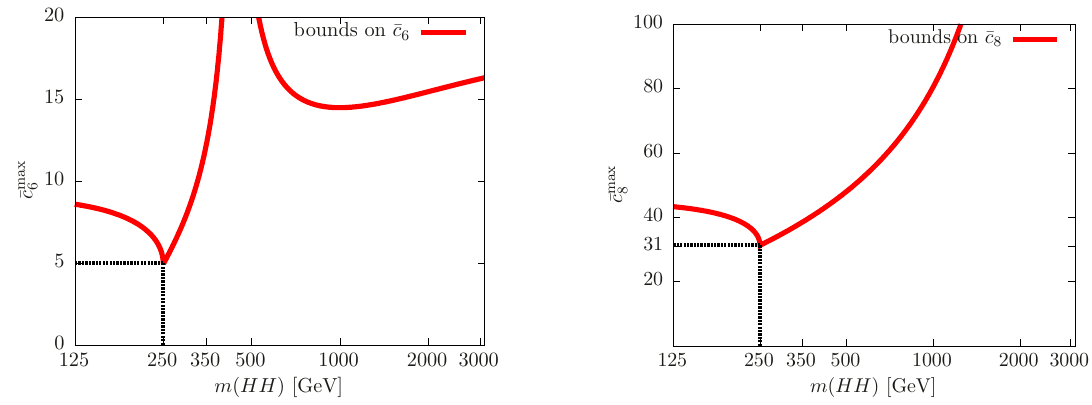
Figure 23 . Maximum value of (cid:22) c 6 (left) and (cid:22) c 8 (right) such that the one-loop corrections to the HHH amplitude are smaller than its tree-level value. We consider two Higgs bosons on-shell and the third with virtuality equal to m ( HH ), showing the dependence on m ( HH